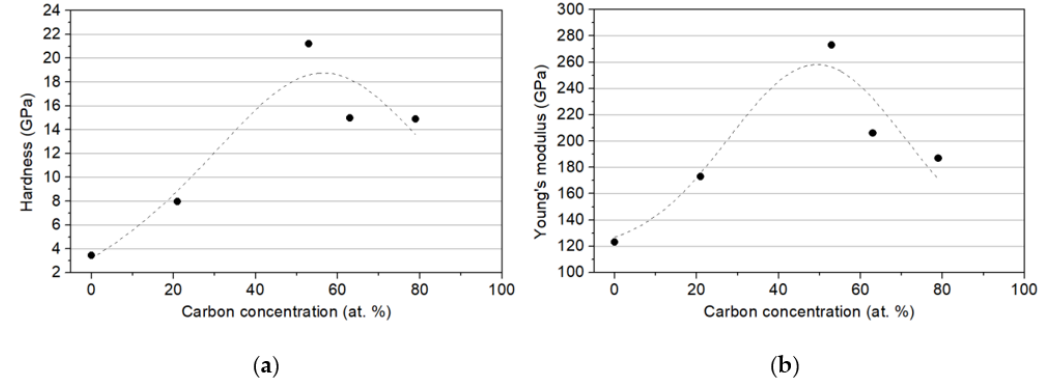
Figure 7. ( a ) Hardness, ( b ) Young’s modulus of deposited coatings depending on carbon concentration.